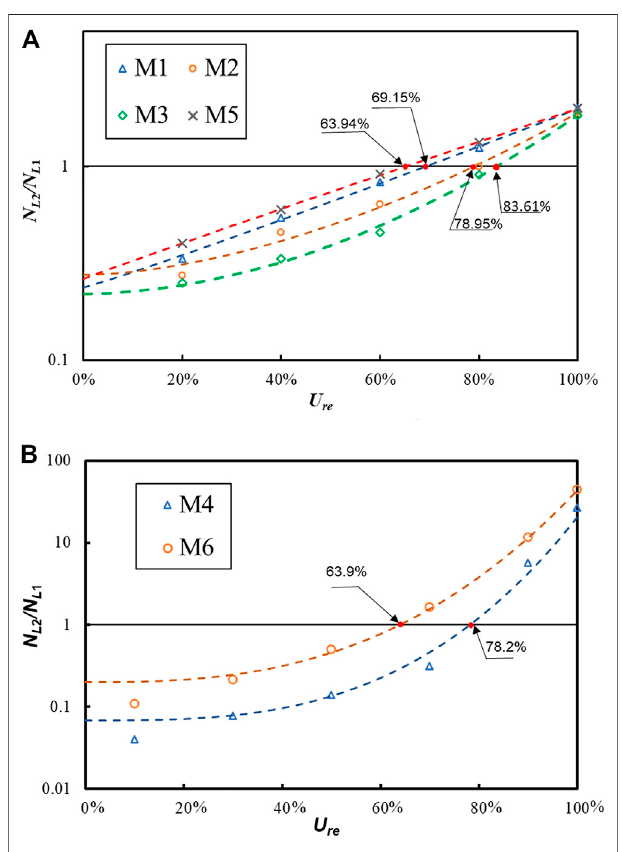
FIGURE 9 | Relationship between the liquefaction cycle number ratio ( N L 2 /N L 1 ) and reconsolidation degrees ( U re ) of tailings: (A) test groups with a CSR of 0.25 and (B) test groups with a CSR of 0.188.